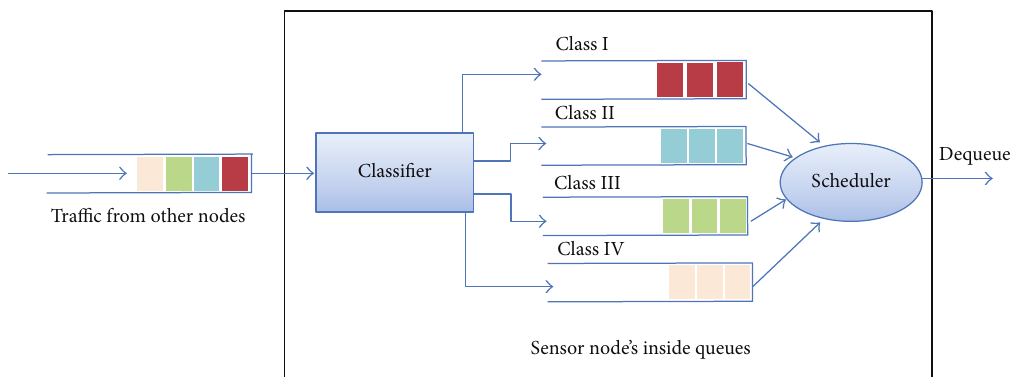
Figure 6: Traffic classification process used in